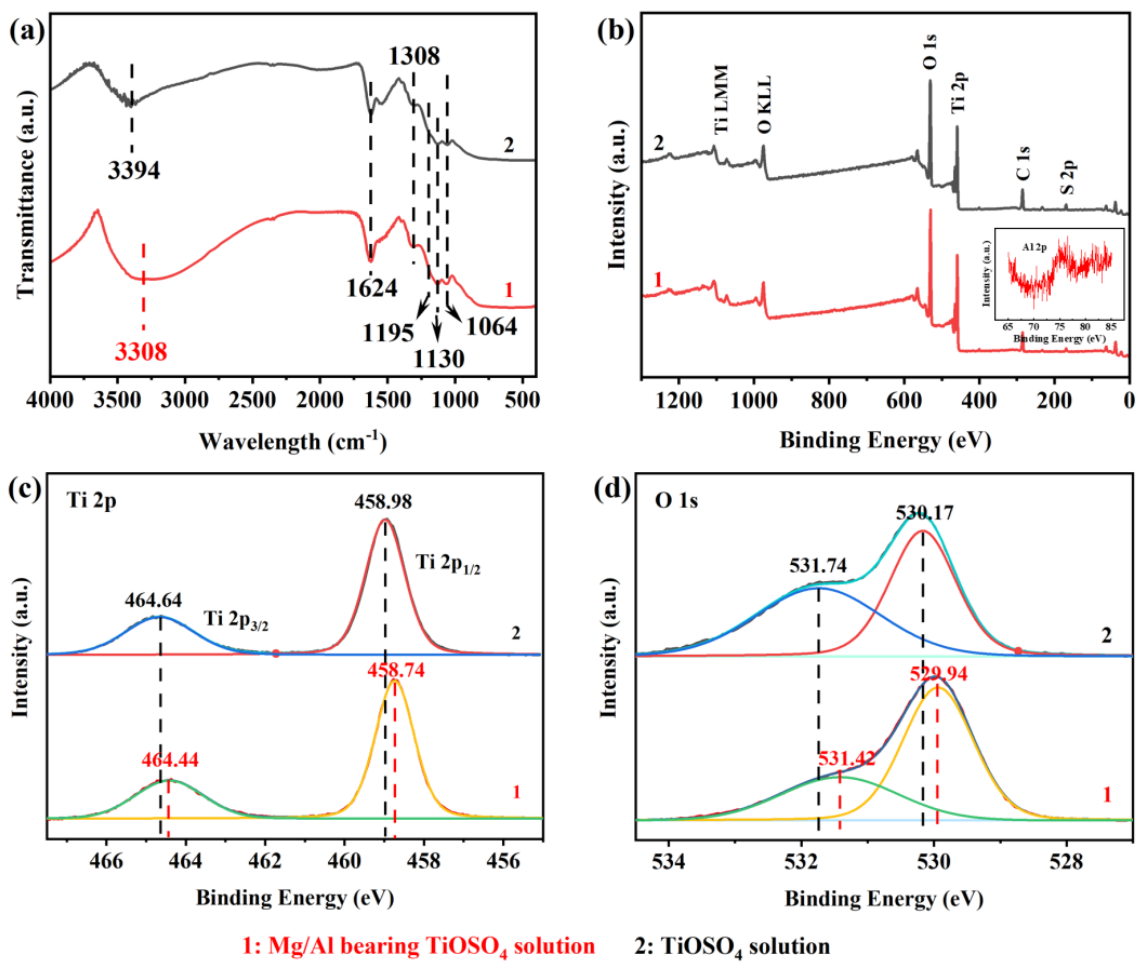
Figure 3. The ( a ) FT-IR patterns, ( b ) overall XPS (with an insert figure of Al 2p XPS spectra), ( c ) Ti 2p XPS and ( d ) O 1s XPS spectra of hydrated TiO 2 in the Mg/Al-bearing TiOSO 4 solution and the TiOSO 4 solution.